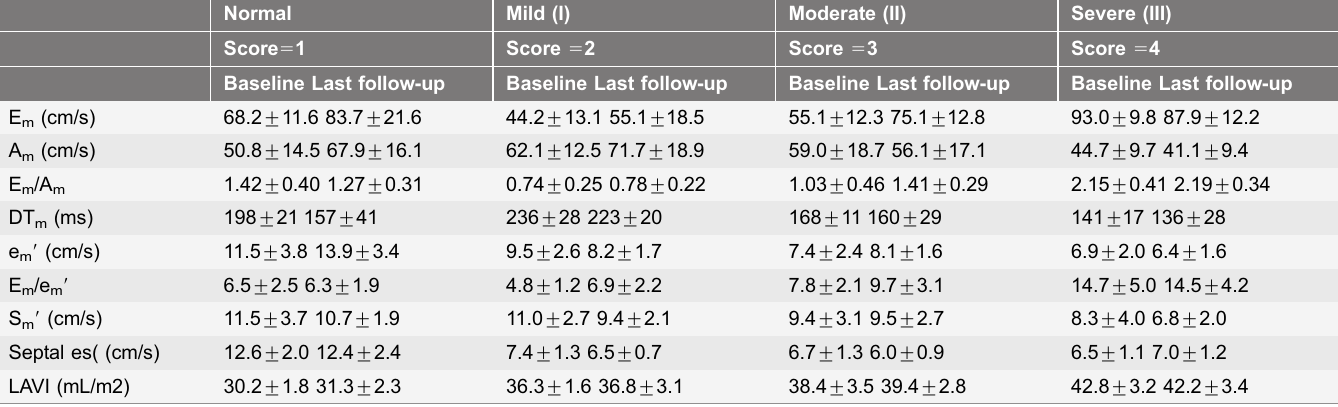
Table 3. Left ventricular diastolic dysfunction (LVDD) at baseline and the last follow-up.